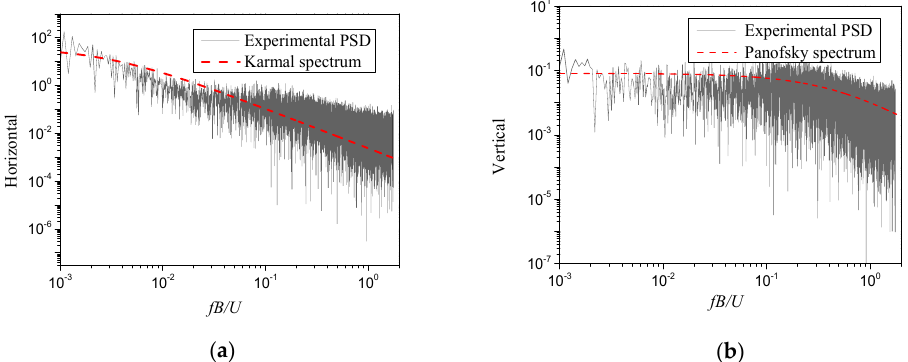
Figure 5. Comparison between experimental and target PSDs: ( a ) longitudinal wind fluctuations; ( b ) vertical wind fluctuations.